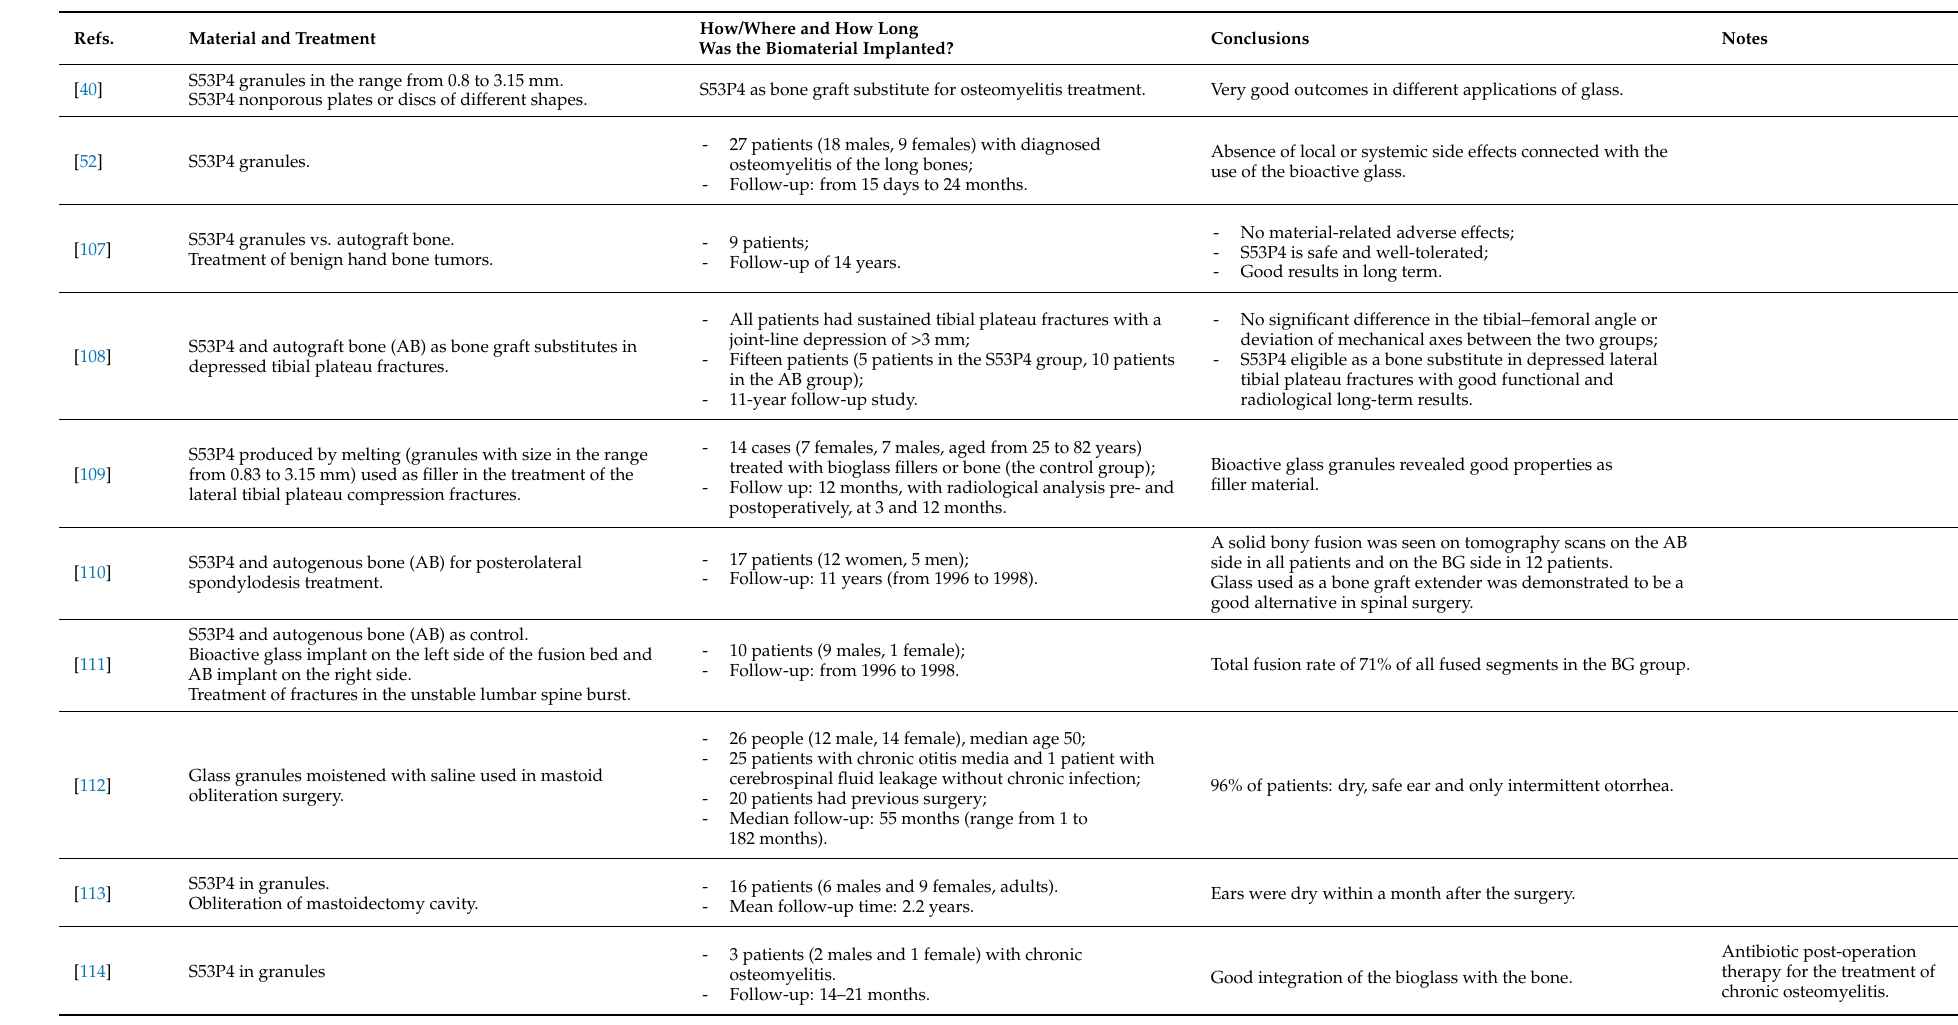
Table 3. The main clinical studies based on the use of S53P4 and its derivate types from 2000 to present.